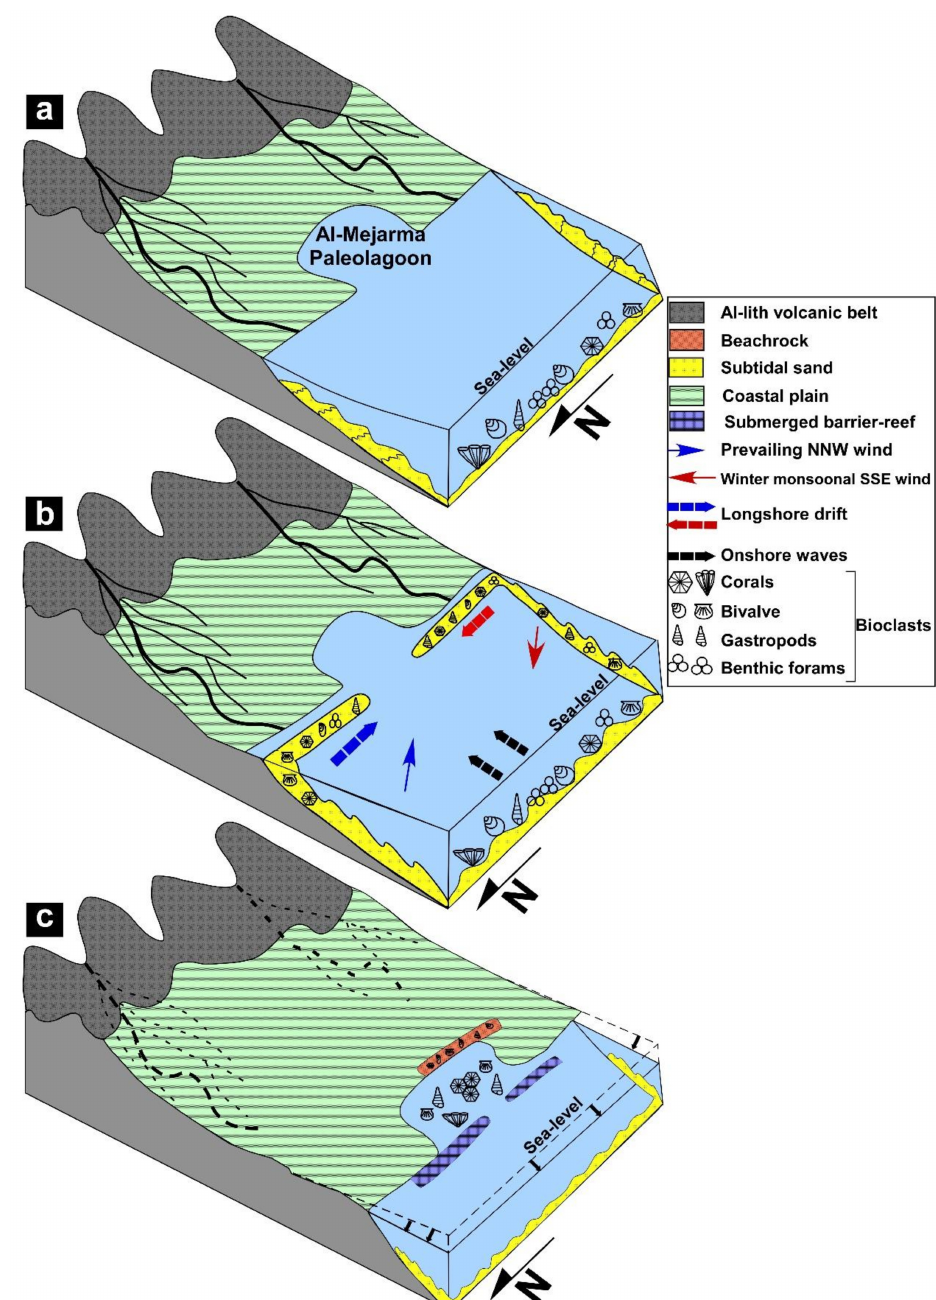
Figure 6. Al-Mejarma coastal evolution and depositional model of beachrock formation: ( a ) A landward extension of Al-Mejarma Lagoon following the post-glacial sea-level rise, where lowland coastal areas were flooded; ( b ) A huge amount of siliciclastic terrigenous sediments were injected through wadis to the north and south into the Red Sea coastal area and offshore. The sediments were prograded landward by the action of onshore waves and longshore drift building a shoreface-beach barrier during mid-Holocene sea-level highstand; ( c ) Finally, the shoreface-barrier sediments were emerged, cemented, and the lagoon shrunk to it its current position following the late Holocene relative sea-level fall and intensive arid